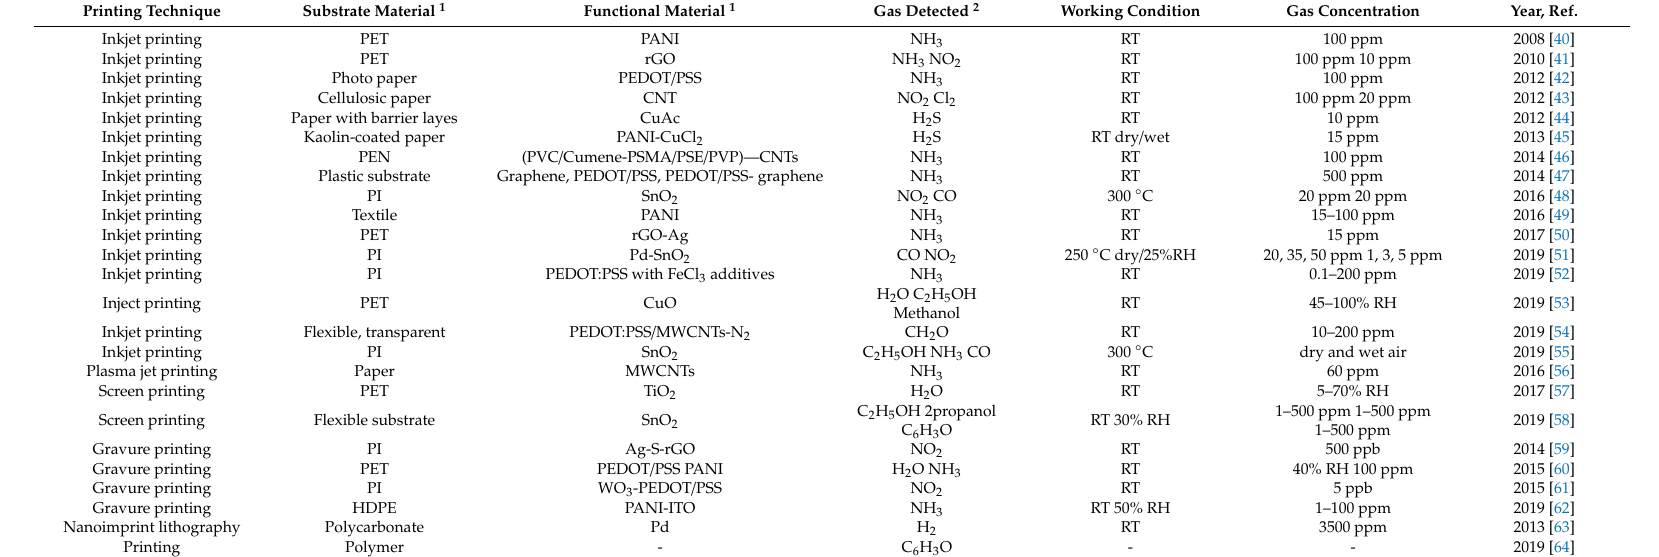
Table 1. Shot of the current state of art about flexible printed chemiresistive gas